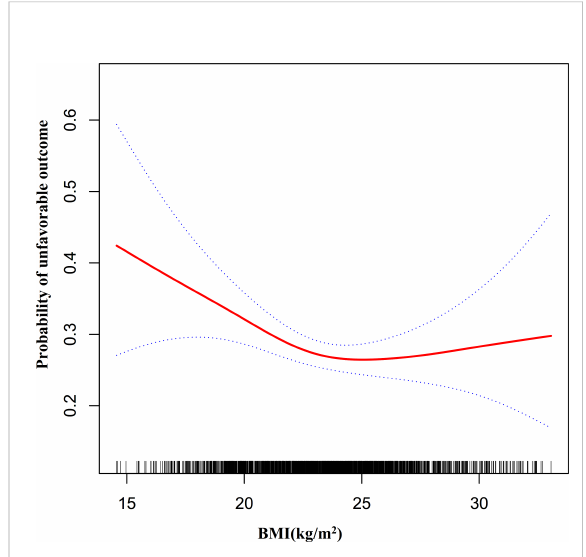
FIGURE 5 The non-linear relationship between BMI and the probability of unfavorable outcomes in all participants.. A non-linear relationship was detected in men with AIS after adjusting for age, LDL-c, HGB, TG, AST, HCT, ALT, BUN, HBA1C, FIB, ALB, previous stroke or TIA, atrial fi brillation, hypertension, smoking, DM, stroke etiology, and NIHSS score. In contrast, in women with AIS, the non-linear relationship between BMI and the risk of unfavorable outcomes in patients with AIS did not